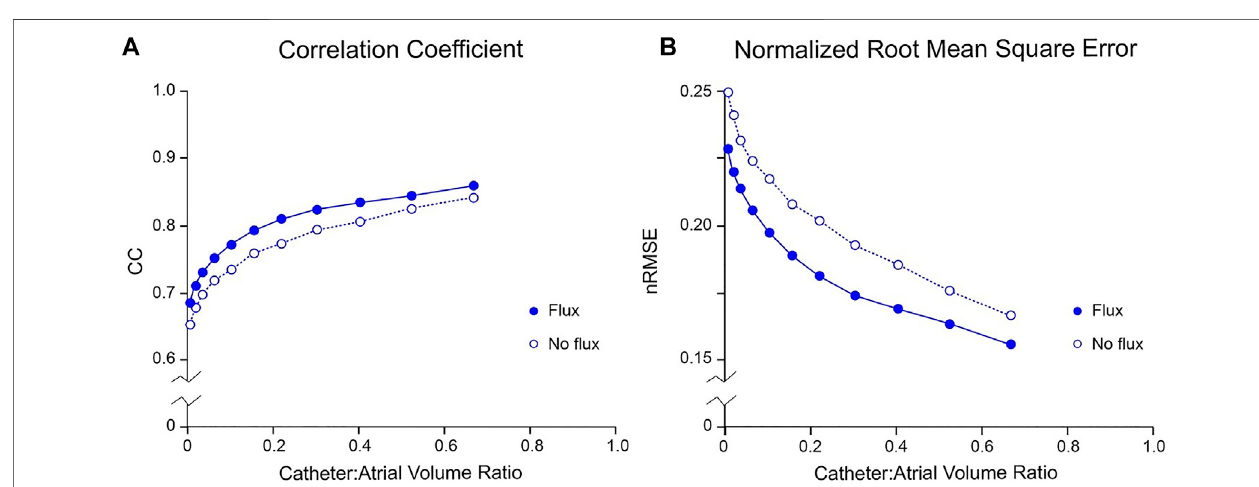
FIGURE4| Effectofboundaryvaluespeci fi cationonaccuracyofinversepotentialmappingusingFEM.Comparisonofgroundtruthpotentialmapsonendocardial surface of LA in SR 43.9 msec after onset of activation with inverse maps reconstructed using FEM from potentials sampled with centrally located internal basket catheters with 64 equi-spaced electrodes. In (A) and (B) , respectively, relative root-mean-squared error (nRMSE) and correlation coef fi cient (CC) are presented as functions of catheter volume relative to LA. Additional error introduced by not estimating normal potential gradients on the virtual surface bounding electrodes is indicated by the no fl ux results (open circles) in which normal potential gradients are set to zero. Abbreviations: FEM, fi nite element method; SR, sinus rhythm.